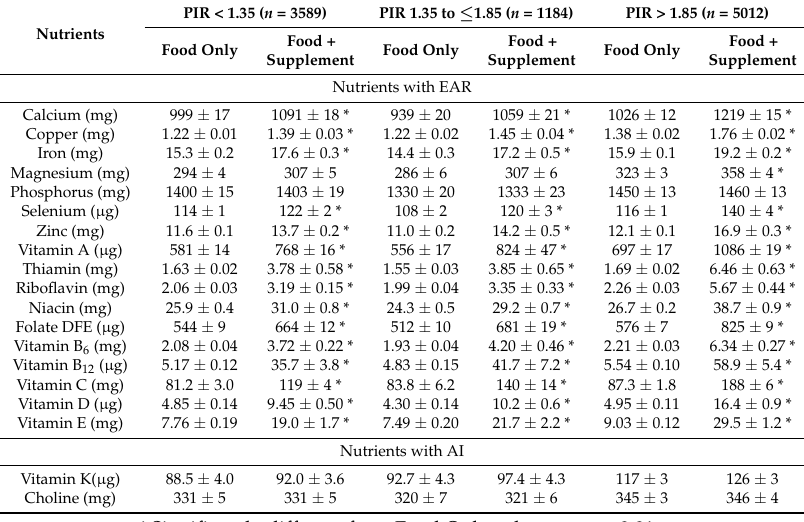
Table 3. Usual intake of nutrients from foods and foods + dietary supplements among